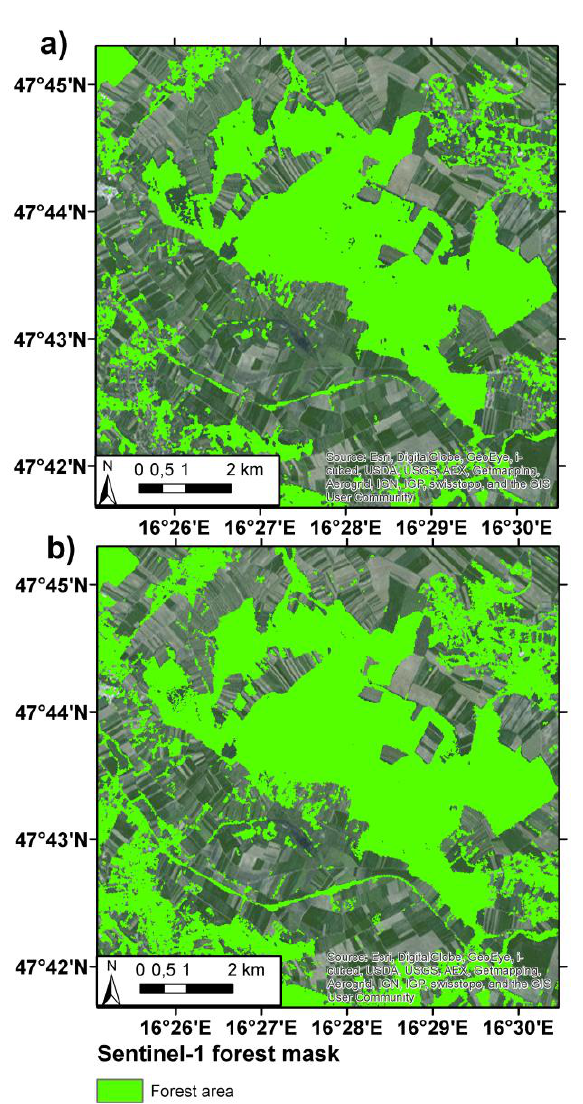
Figure 4: 10 by 10 km training area: a) result of the thresholding approach classification, b) result of the k-means clustering approach